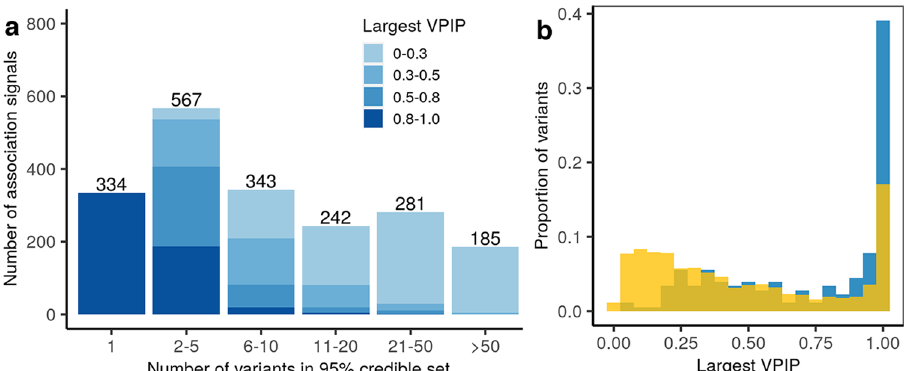
Fig. 4 The 1952 of the 2030 metabolite genetic association signals identi fi ed in stepwise conditional tests with SPIP ≥ 0.95 in DAP-g Bayesian fi ne mapping. a Numbers of variants in the 95% credible sets and distribution of variant posterior inclusion probabilities (VPIPs) for the most likely causal variants within the 95% credible sets. b Density plot of largest VPIPs highlights the variants with > 10-fold greater frequency in METSIM than non-Finnish Europeans (gnomAD v3.1; blue) have larger VPIPs than all other variants